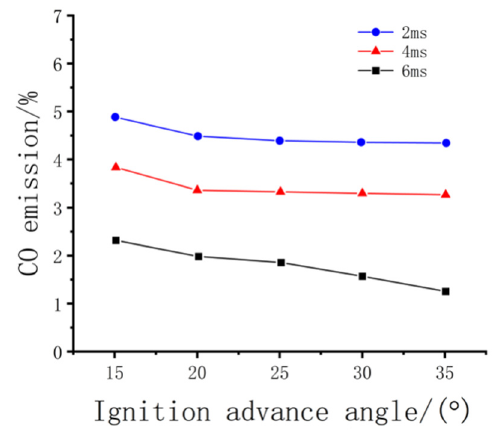
Figure 29. Effect of the ignition parameters on CO emissions.